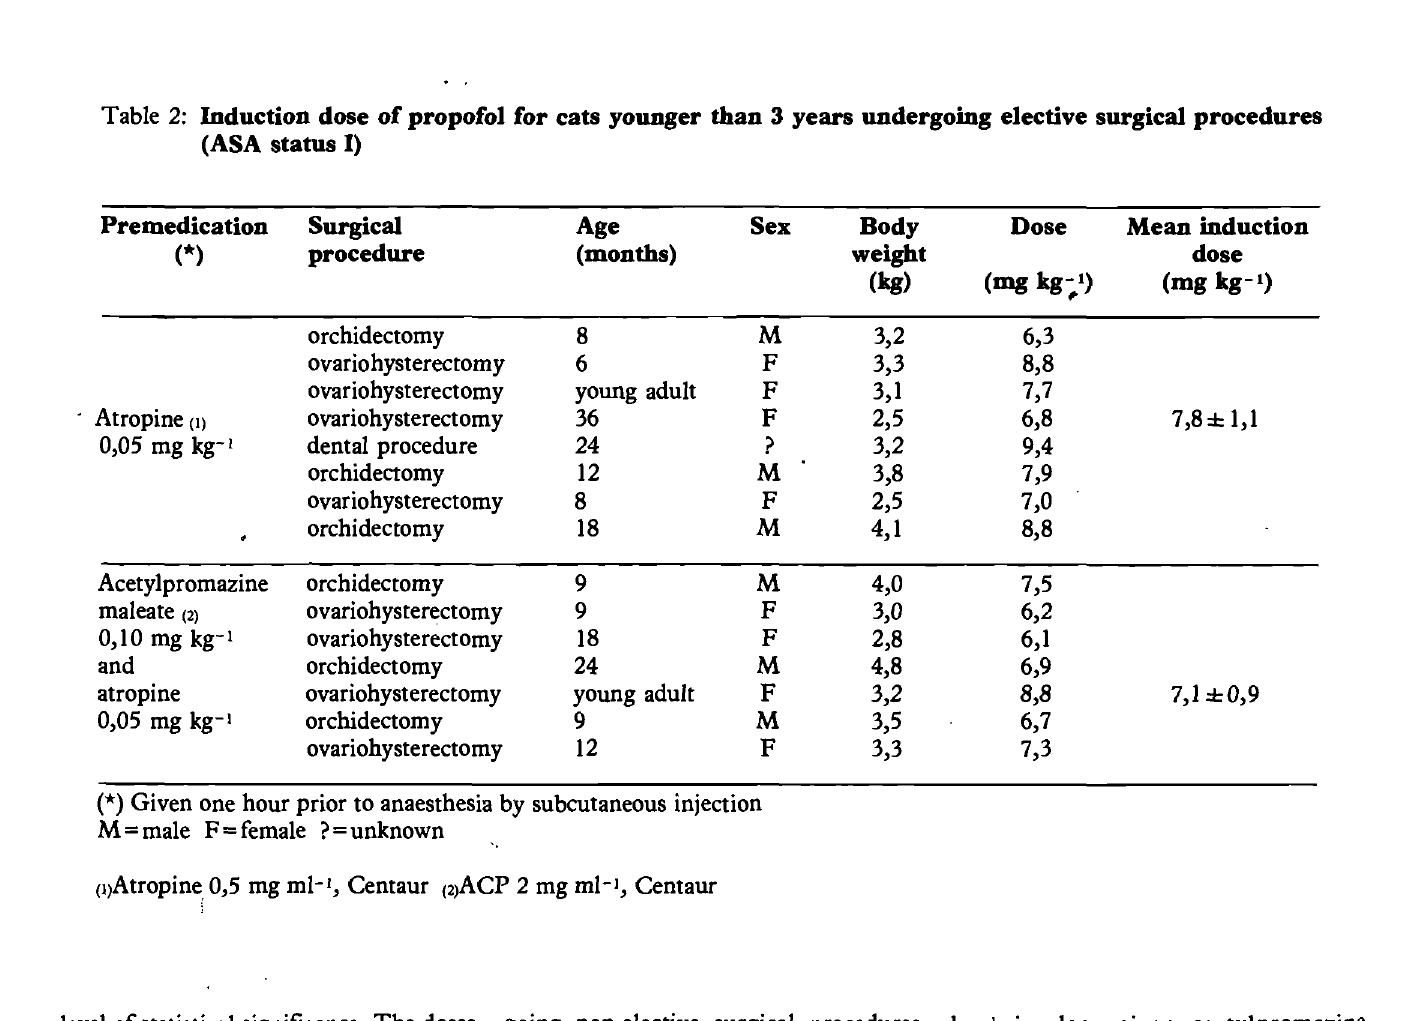
Table 2: Induction dose of propofol for cats younger than 3 years undergoing elective surgical procedures (ASA status